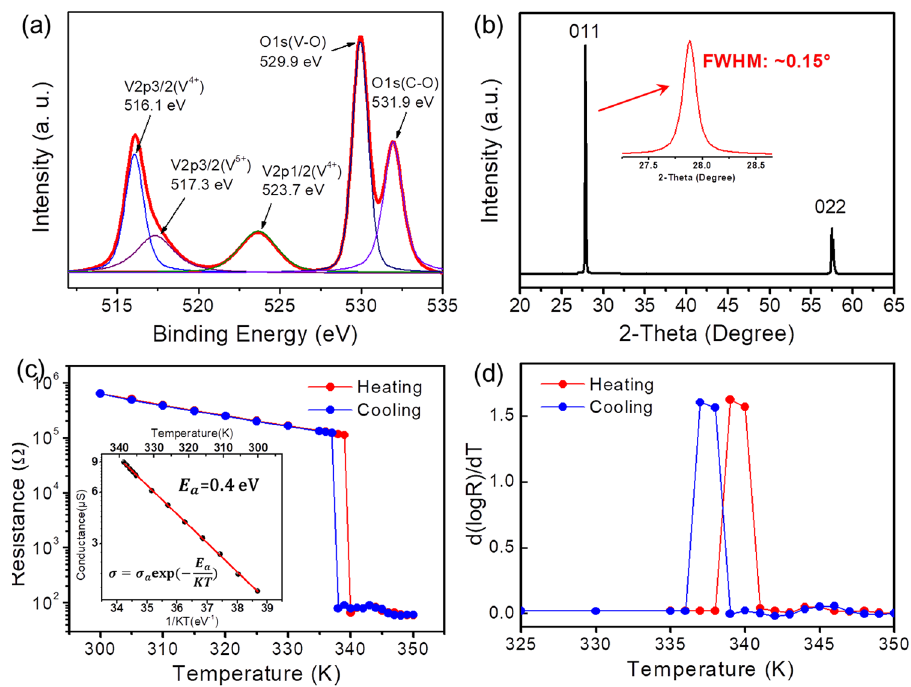
Figure 4. (a) High-resolution XPS profile of V 2p and O 1 s and (b) XRD pattern collected from the final VO 2 film structure. (c) Temperature-dependent resistance measurements of the final VO 2 film structure, and (the inset) conductance as a function of inverse temperature showing an activation energy of 0.4 eV. (d) The derivation curve during the heating and cooling